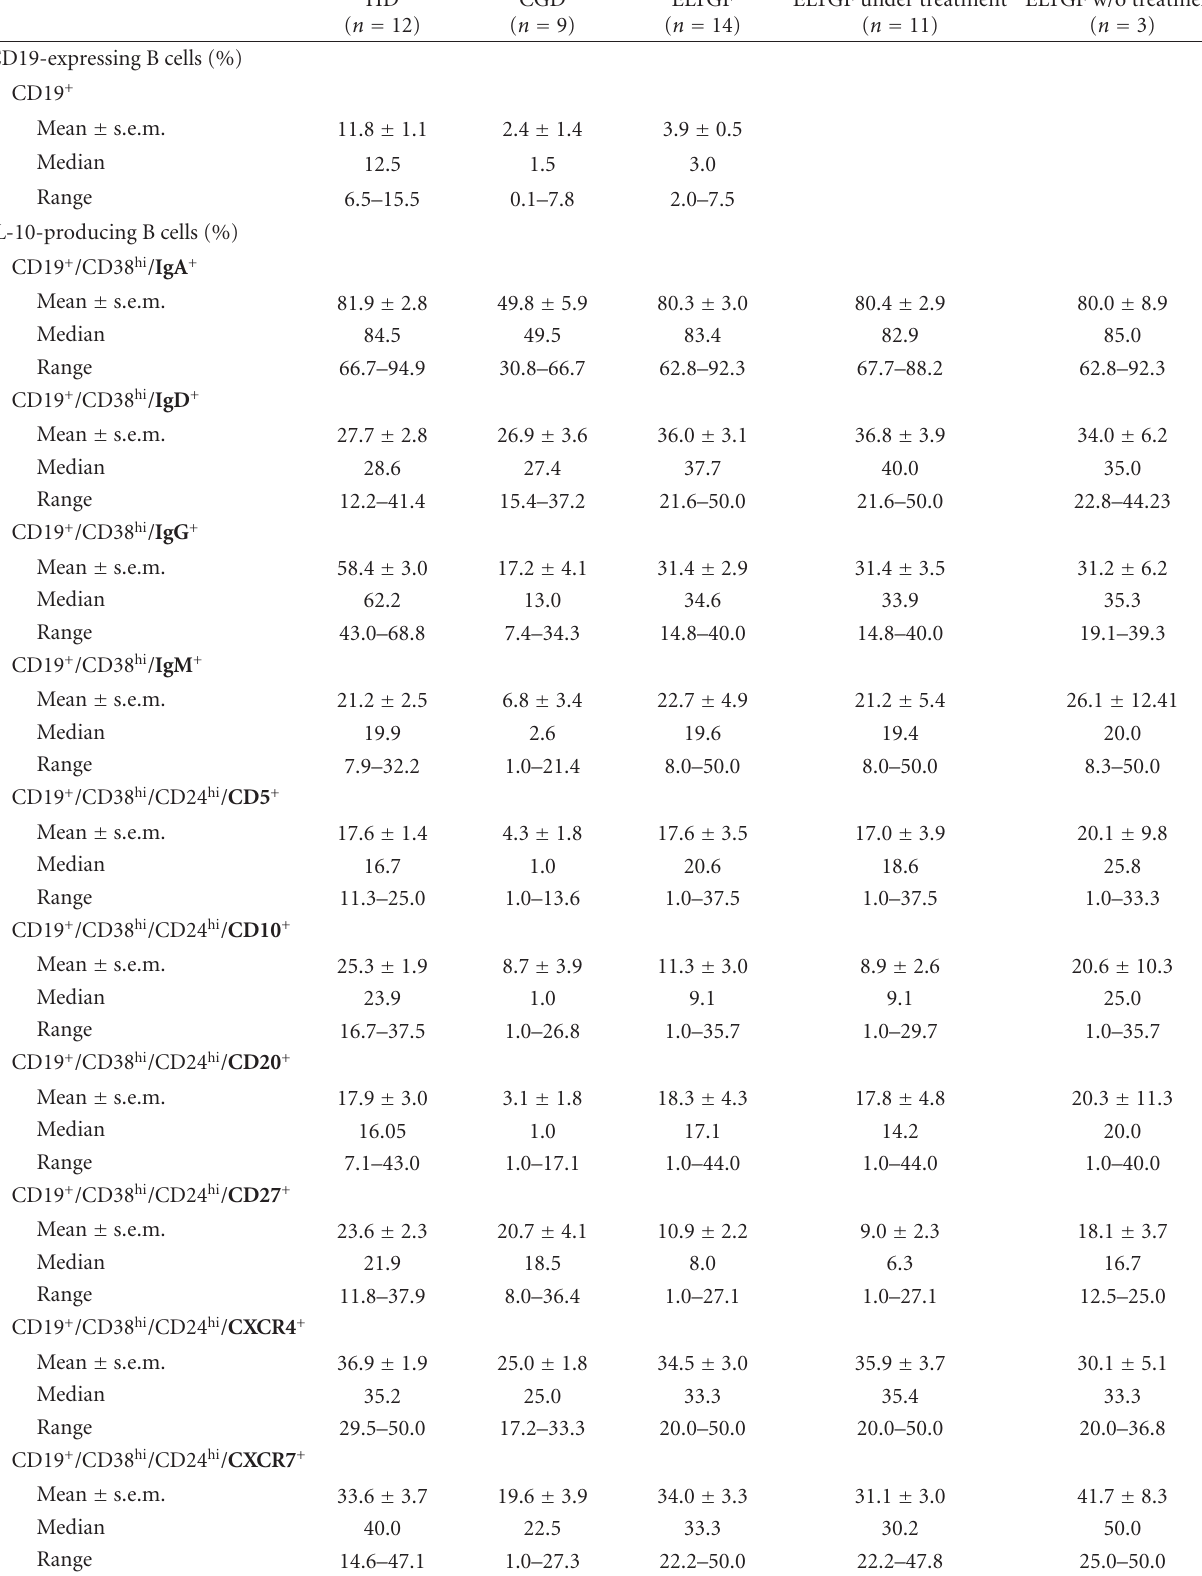
Table 2: Percentage of IL-10-producing B cells, IDO- and Tregs-circulating cells in KTR patients.